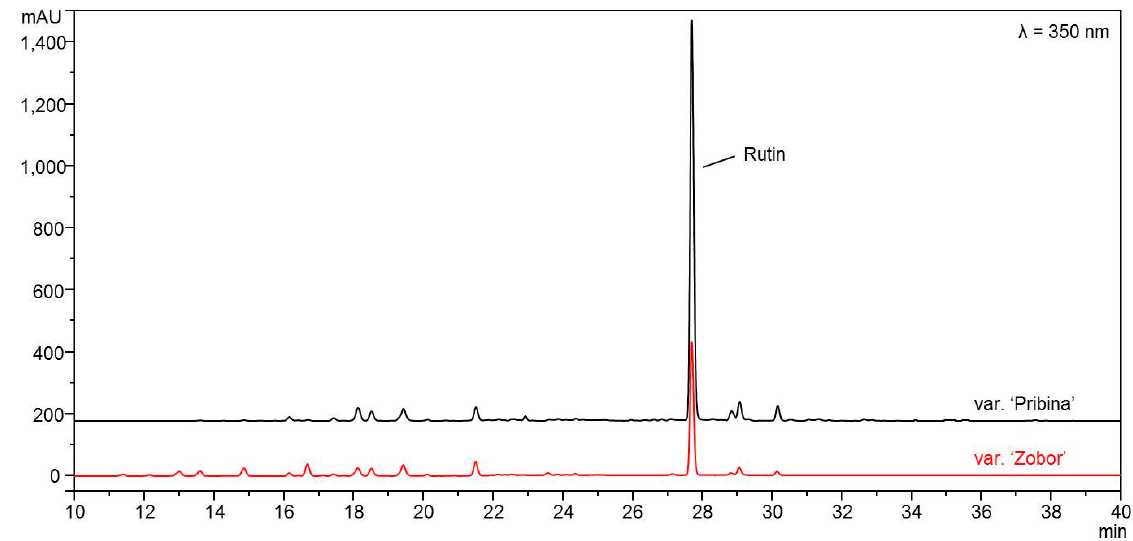
Figure 1. HPLC-DAD chromatograms of ethanol leaf extracts of two new Slovak amaranth varieties, Amaranthus cruentus L. variety ‘Pribina’ and Amaranthus hypochondriacus × Amaranthus hybridus L. variety ‘Zobor’.